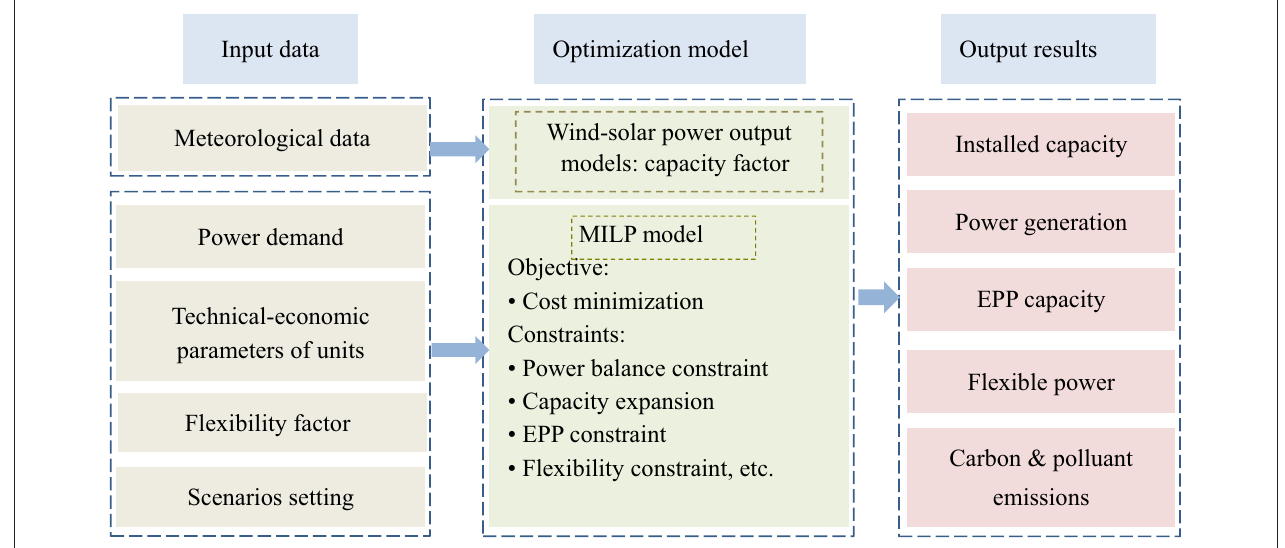
FIGURE 1 | Research